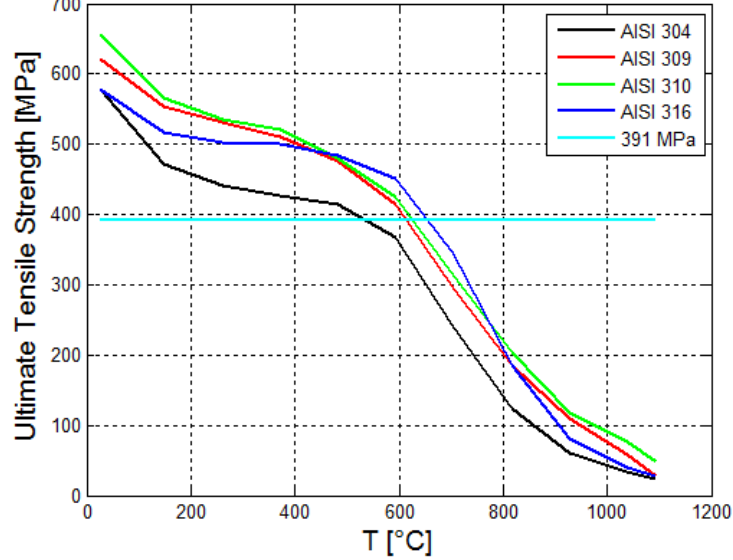
Figure 26. Plot of ultimate tensile strengths (UTS) of several stainless steels compared to the stress obtained by COMSOL software (horizontal line) shown as a function of temperature (The thermo-mechanical data were taken from Reference [43]).